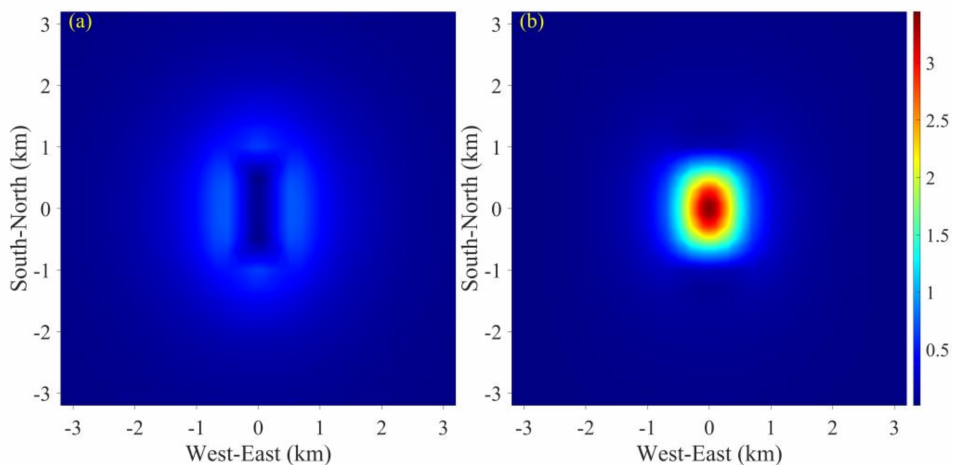
Figure 6. Anisotropy index for a frequency of 0.57 Hz. ( a ) The COMMEMI 3D-1A model. ( b ) The modified COMMEMI 3D-1A